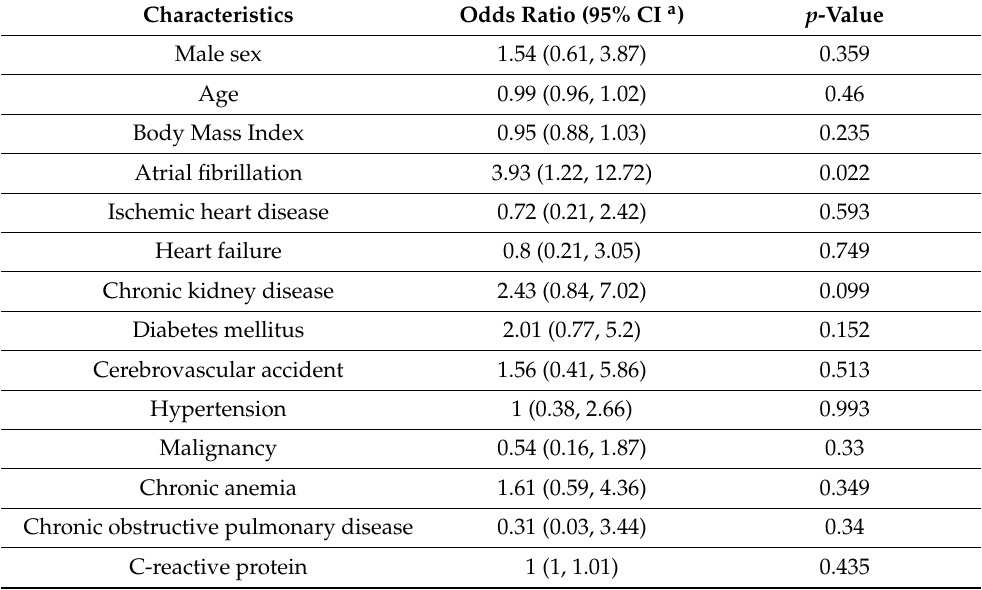
Table 3. Predictors for decreased folate levels in the presence of COVID-19 diagnosis.